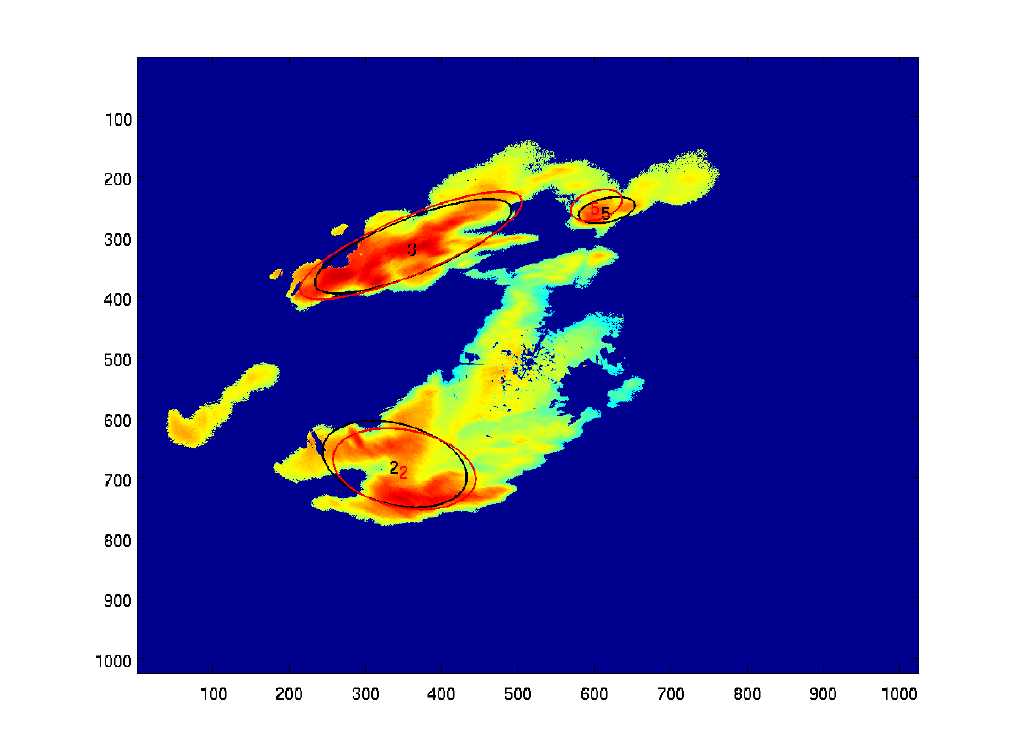
Figure 13. Forecasted (red) storms with corresponding original storms